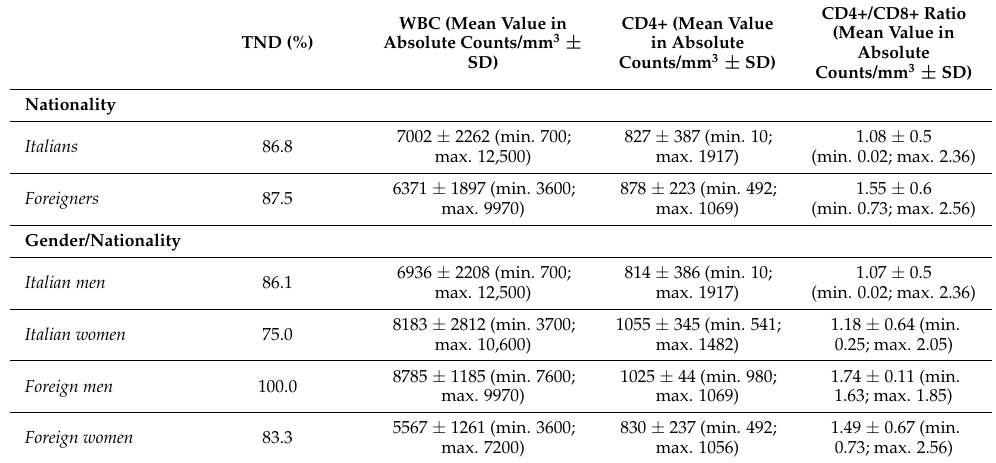
Table 2. Details of laboratory parameters in the HIV+ sample according to gender and